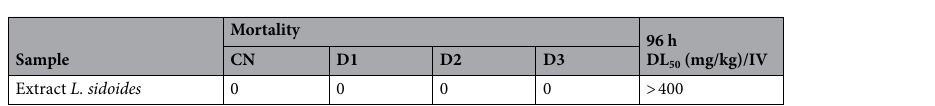
Table 2. Acute toxicity test results (96 h). CN- Negative control group: DMSO 3%. D1—Dose 1 (40 mg/ kg). D2—Dose 2 (200 mg/kg). D3—Dose 3 (400 mg/kg). LD50-Lethal dose to kill 50% of adult Zebrafish; IV-confidence